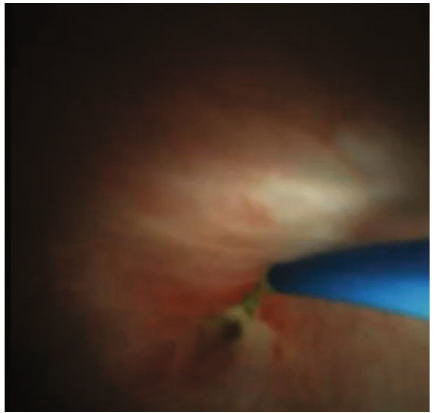
Figure 8: With F-URS, the infundibulum of the calyceal diverticulum is incised with the holmium laser.